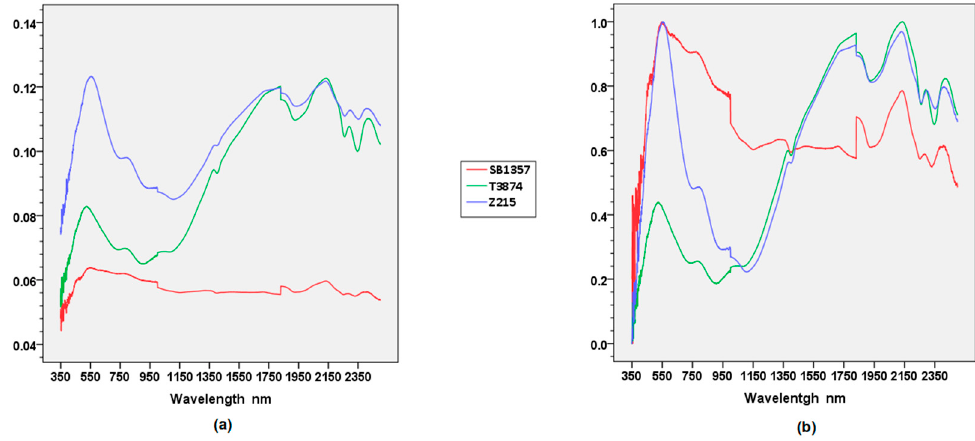
Figure 5. Plot of T3874, Z215, and SB1357 using ( a ) raw data, and ( b ) modified data by the affine transformation.